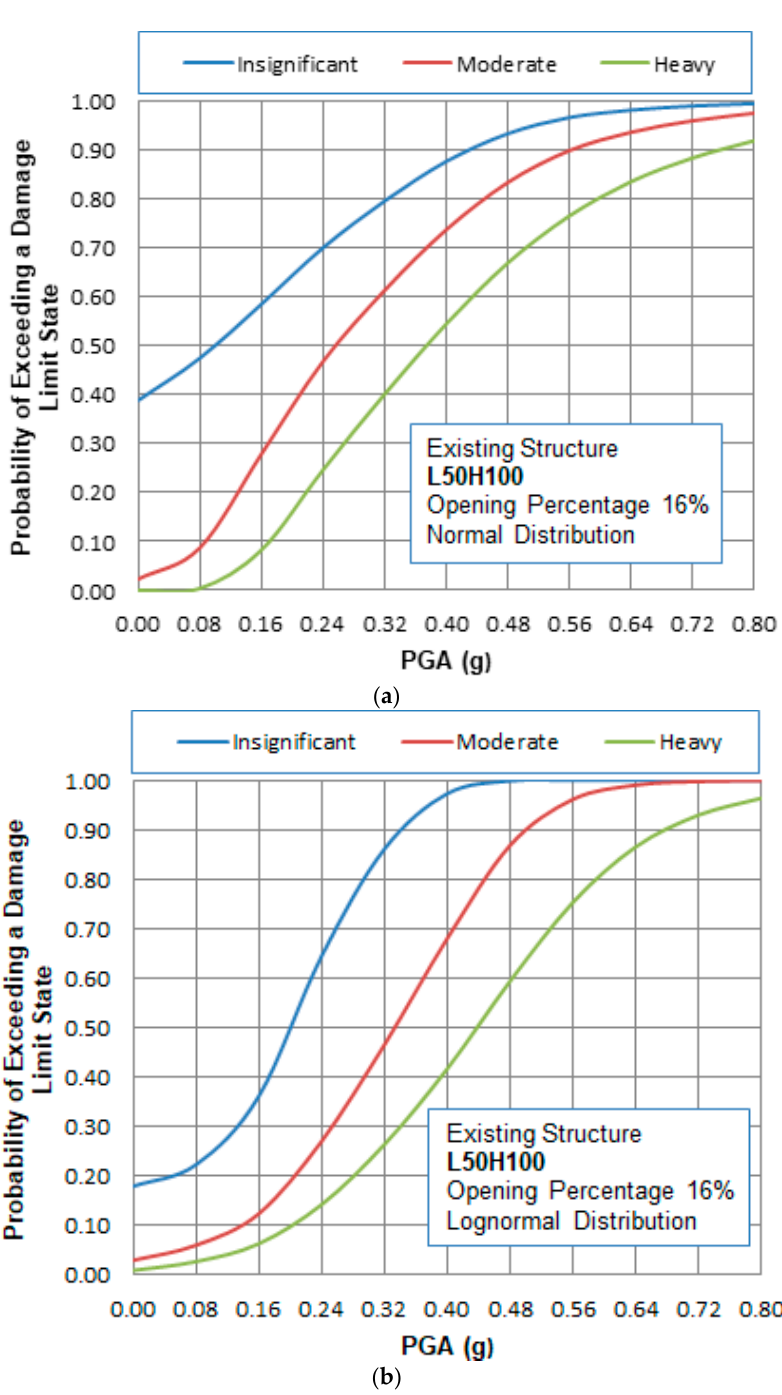
Figure 42. Fragility curves of wall L50H100 in its current condition, considering the Syrmakezis et al. (1995) failure criterion [8,25] and for an opening percentage of 16%: ( a ) normal distribution; and ( b ) lognormal distribution.